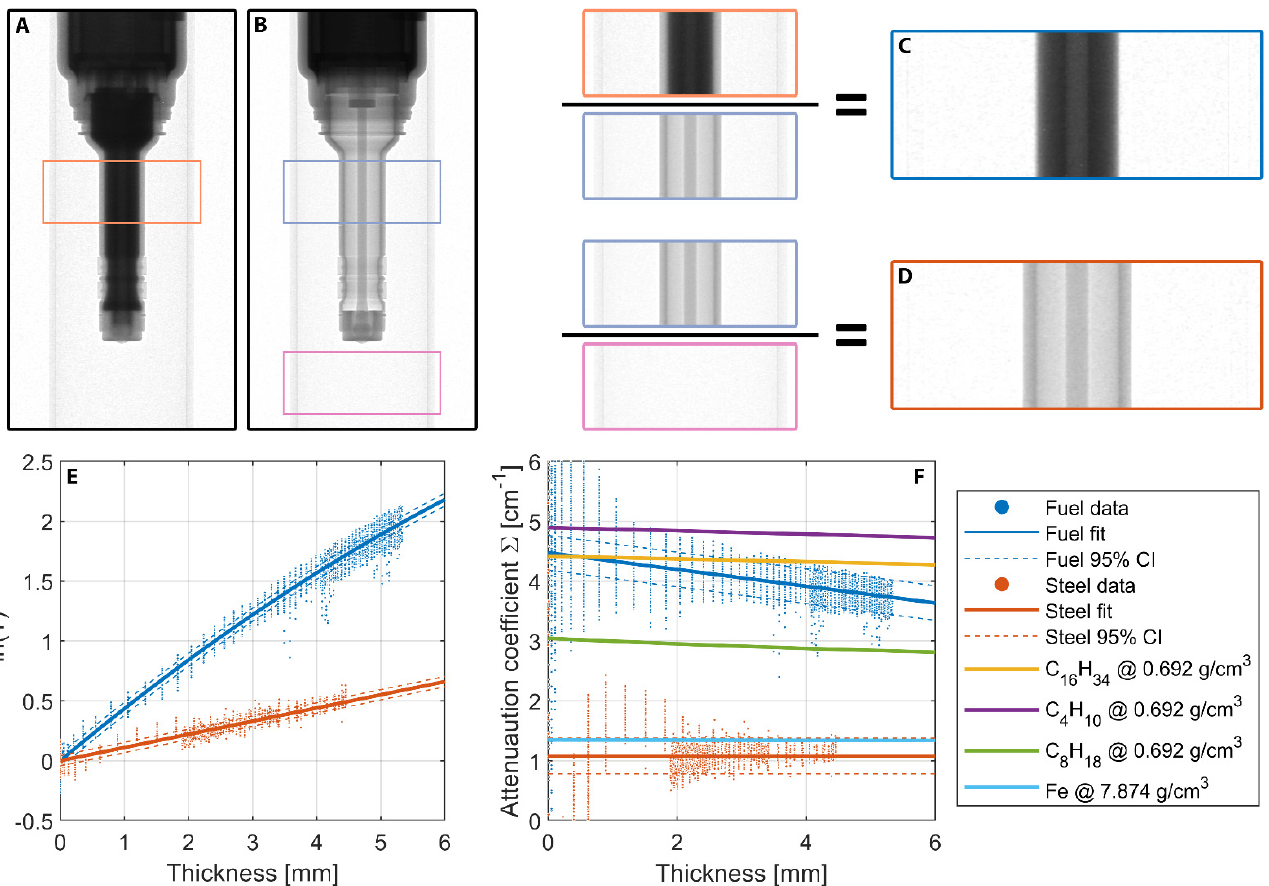
Figure A2. Measurement of macroscopic attenuation coefficients for fuel and injector. ( A ) Radiograph of fuel-filled injector in Al sample holder. ( B ) Radiograph of empty injector in Al sample holder. ( C ) Normalization of same axisymmetric region in fuel-filled and empty injector radiographs results in transmission image of the fuel. ( D ) Normalization of the empty injector by an empty region of the axisymmetric sample holder results in transmission image of the injector. ( E ) Plot of − ln( T ) vs. material thickness at each pixel in C and D shows a linear response for the steel injector and a non-linear response for the iso-octane fuel, indicating that beam hardening and scattering effects from the fuel are significant in this geometry. ( F ) Same data from E plotted as macroscopic attenuation coefficient Σ are compared to predictions from NEUIT for three hydrocarbons and